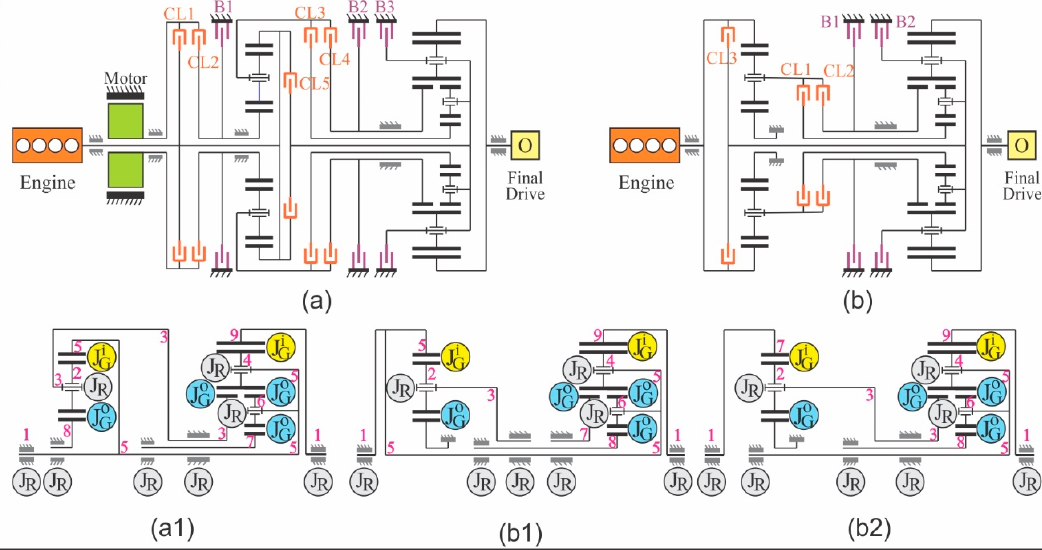
Figure 3. Schematic diagrams of existing HT designs: ( a ) Patent No. US 7,448,975, and ( b ) ZF-6HP26.